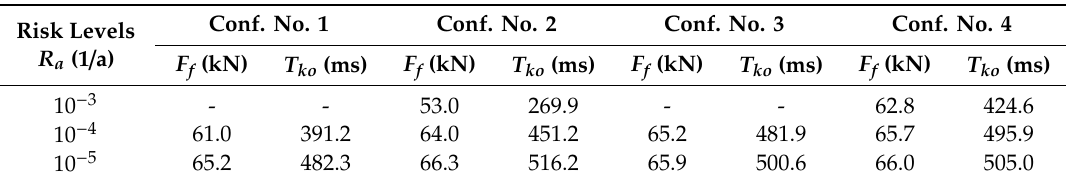
Table 6. Force F f and time T ko values for defined risk levels and di ff erent PSPA configurations under short circuit conditions at point